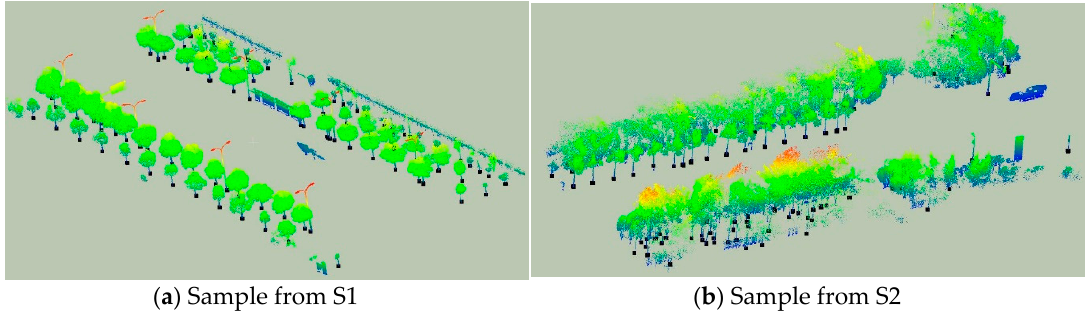
Figure 10. Resulting samples of localization of trees and road poles.